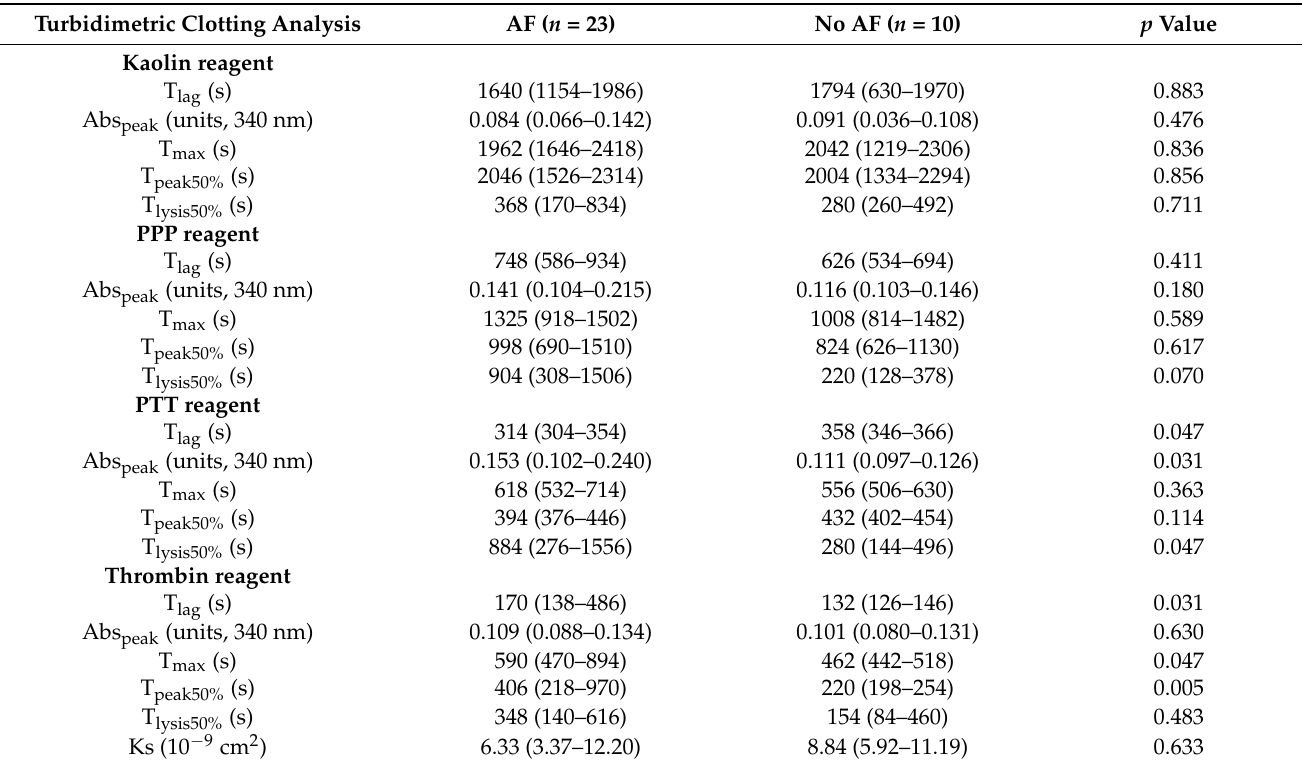
Table 3. Fibrin clot properties among patients with and without atrial